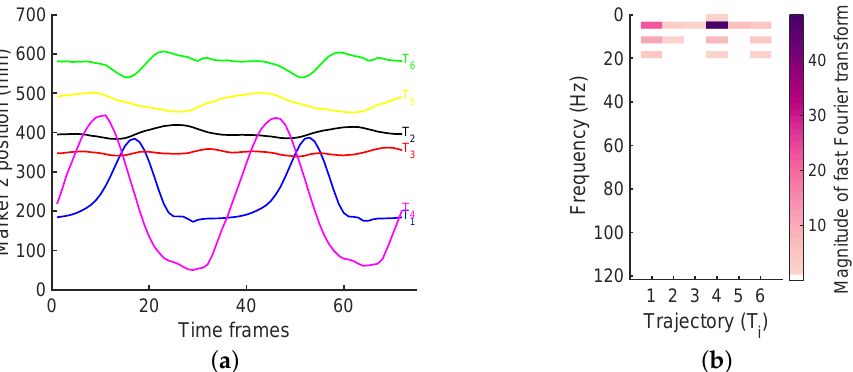
Figure 1. ( a ) An example set of marker trajectories from human gait data. ( b ) The corresponding frequency